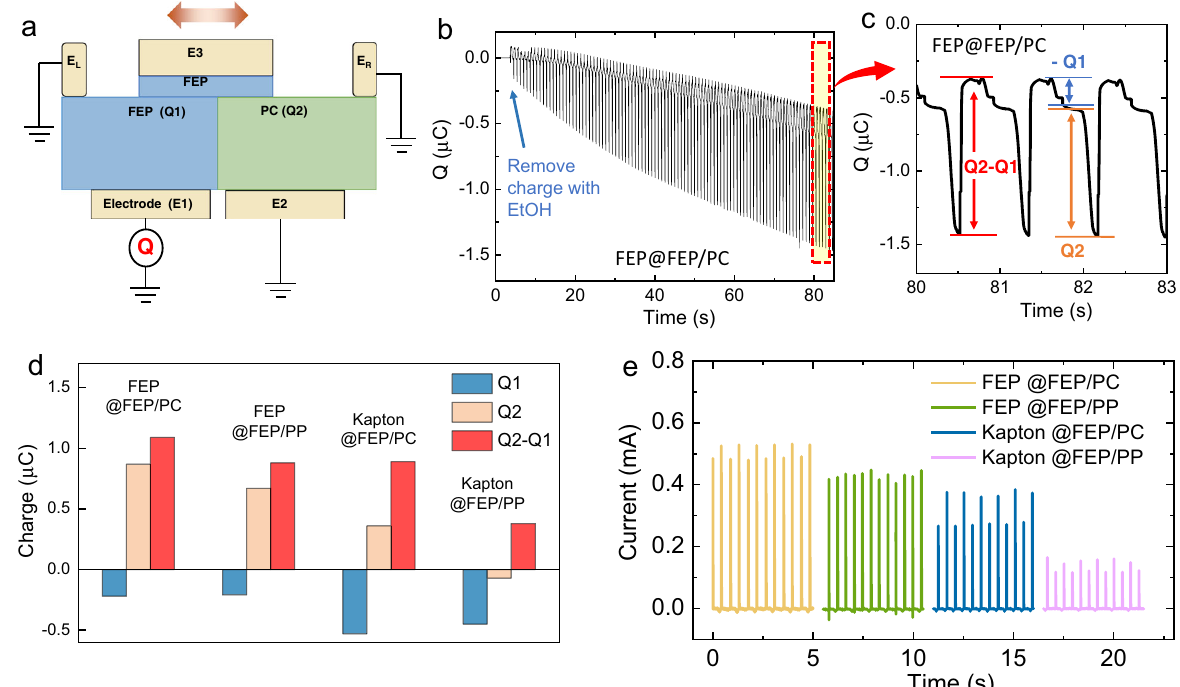
Fig. 4 “ Four-ports ” methodology for evaluating the charge output. a Schematic of the “ four-ports ” methodology for evaluating the charge output of the OCT-TENG. b Charge accumulation measured by the “ four-ports ” method. c charge on the FEP surface Q 1 , charge on the PC surface Q 2 , and the output (cid:2) Q charge of the OCT-TENG Q measured by the “ four-ports ” method. d Measured Q 2 1 the tribo-surface of the slider as A and that of the stator as B and C). e Current output of the OCT-TENG (full circuit shown in Fig.1a) with various material systems (load resistance: 4.7 M Ω